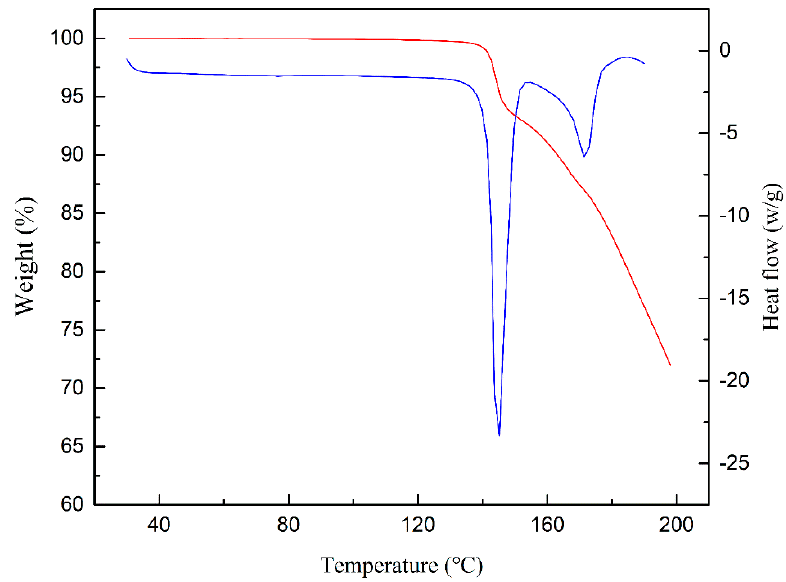
Figure 9. The overlaid thermogravimetric analysis (TGA) and differential scanning calorimetry (DSC) curves of